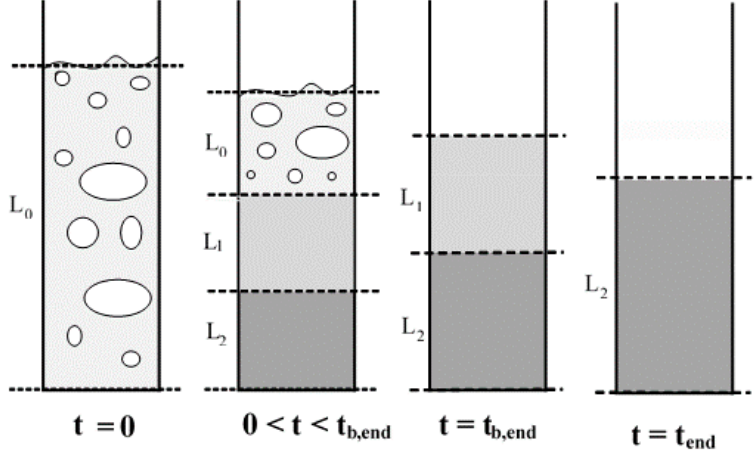
Figure 4. Schematic of the stepwise collapse process of Geldart group A particles .